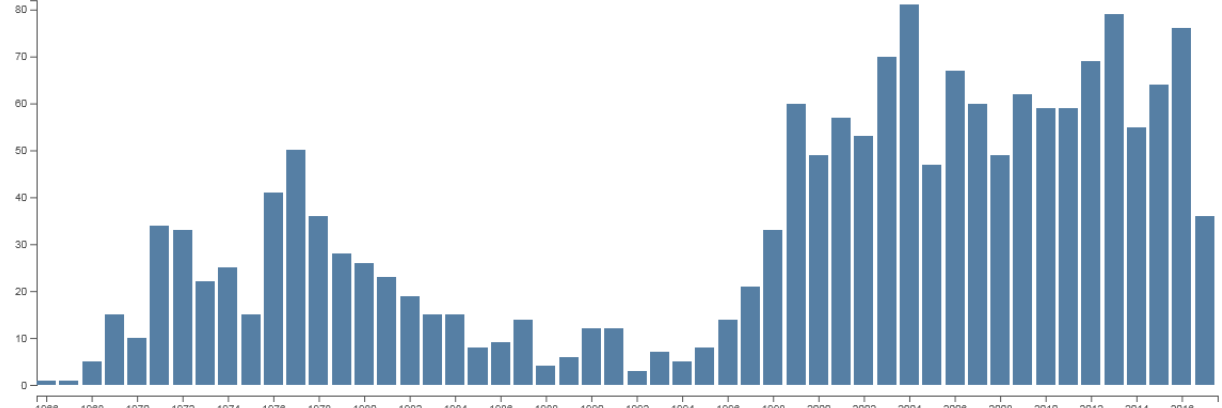
Figure 2. Number of scientific papers including the term “superheavy elements” in the title. Source: Web of Science